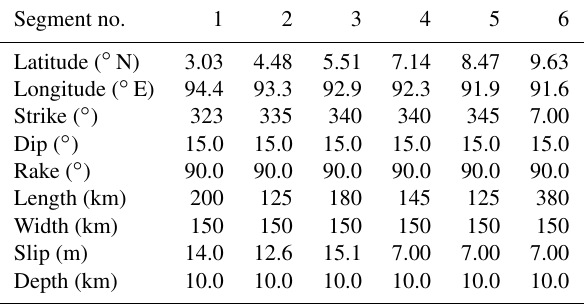
Table 1. Earthquake fault parameters for calculating initial water level (Suppasri et al.,